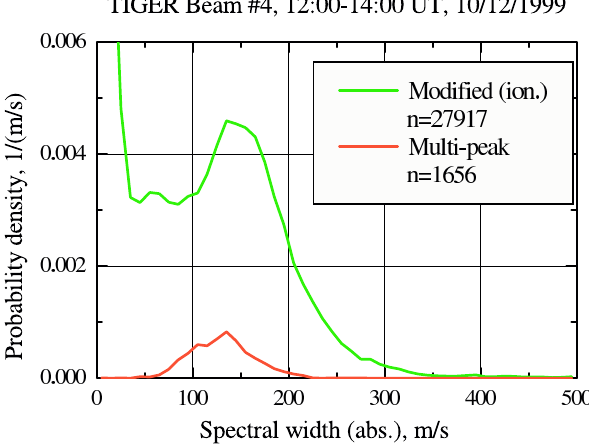
Fig. 12. The same data as in Fig. 7 (green line) but without sea scatter